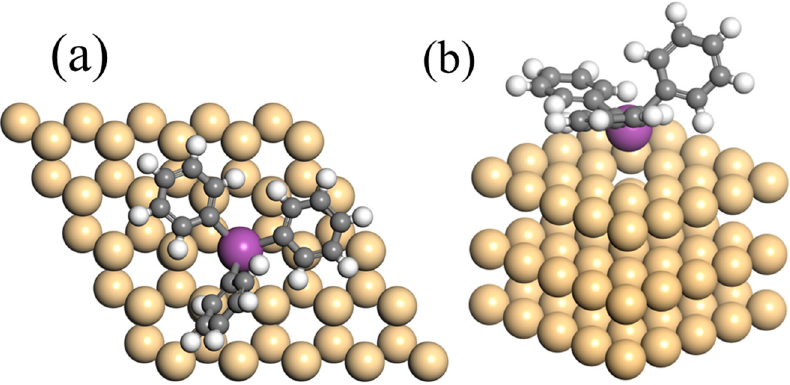
Figure 5. Optimized structure of a TPB molecule attached to a vacancy site on Cd(0001) surface. ( a ) Top view of a TPB molecule sitting on the single-atom pit. ( b ) Three-dimensional sketch of the adsorptional model of TPB on Cd(0001).